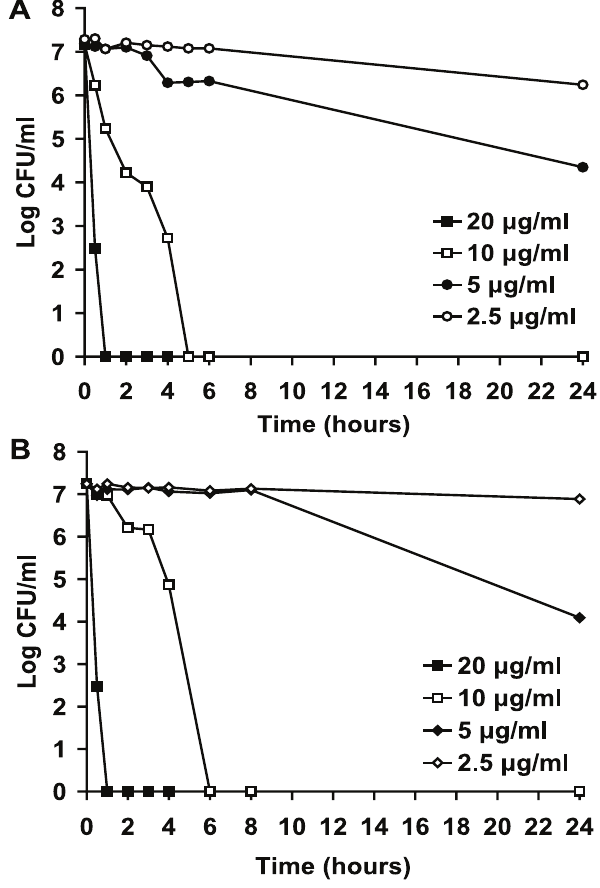
Figure 3. Speed of kill with HT61 against non-multiplying MSSA and MRSA. HT61 was incubated with MSSA (A) and MRSA (B) at different concentrations for 24 hours. At different time points, CFU counts were